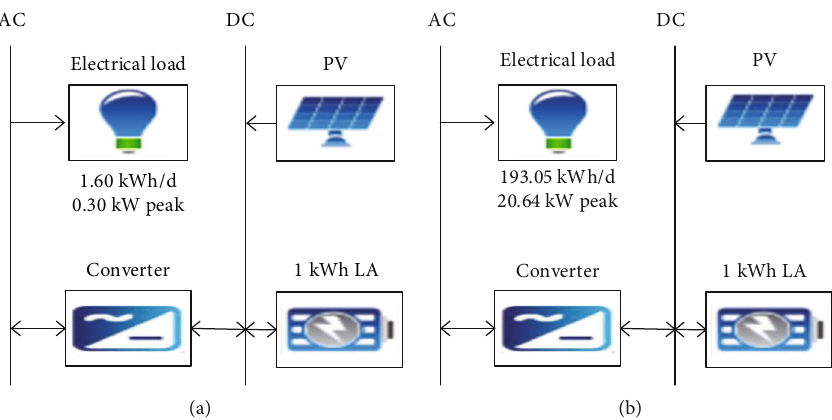
Figure 6: Various types of photovoltaic solar systems: (a) the standalone photovoltaic for a single residential household and (b) the PV microgrid system for the rural community in the o ff -grid Table 4: Comparative simulation analysis for the proposed PV systems (we did not consider the sensitivity variables). Resource System architectures